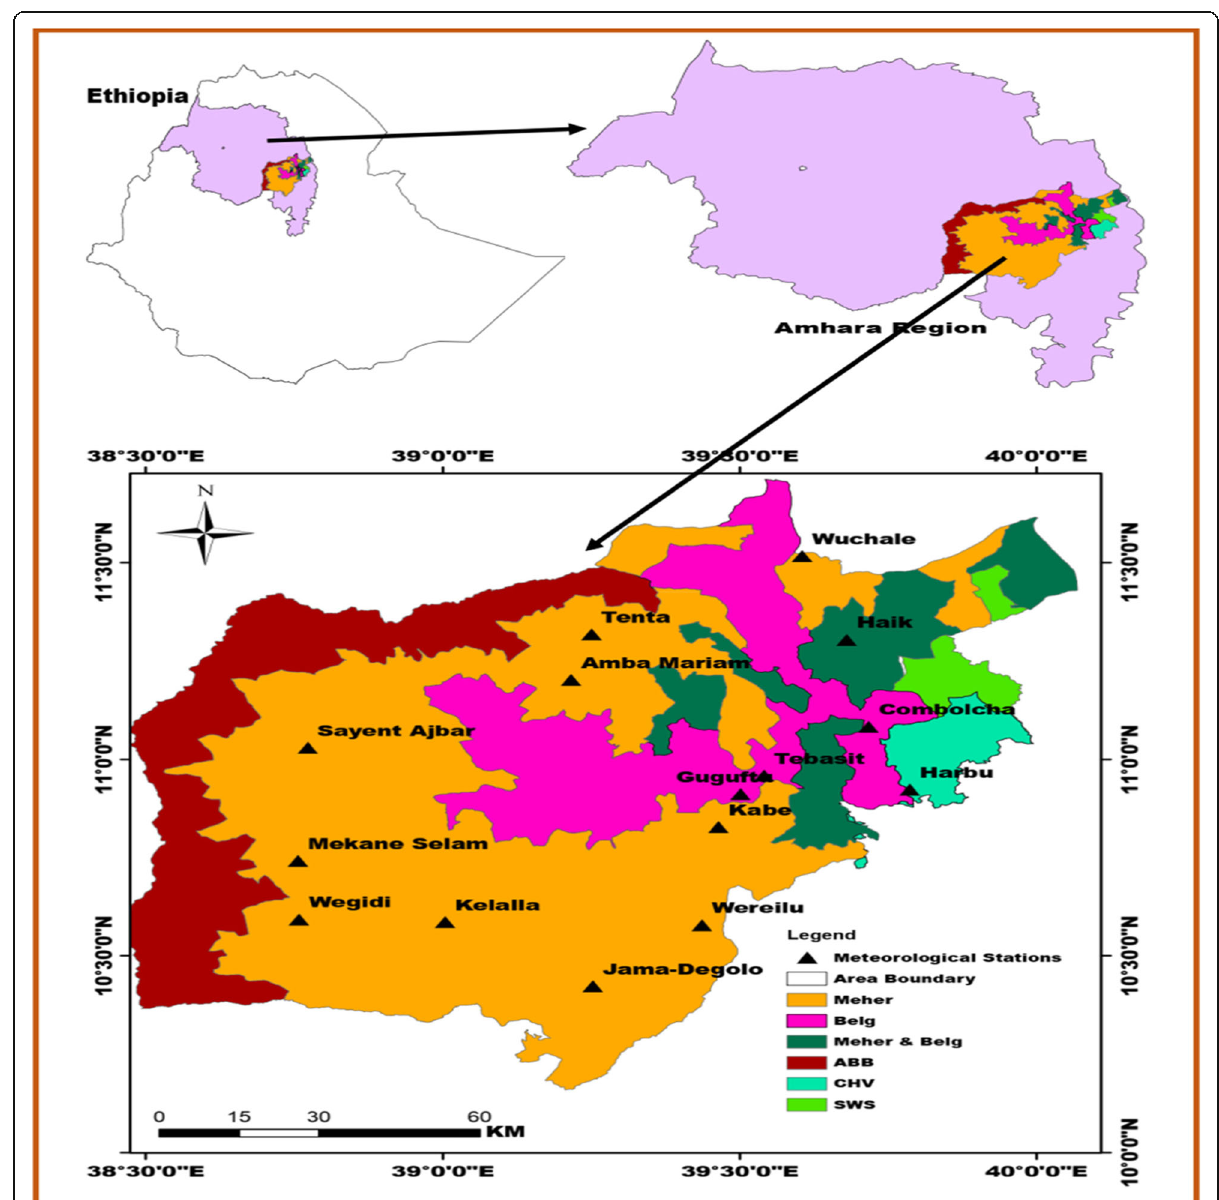
Fig. 1 The geographic location of livelihood zones of South Wollo and Meteorological stations. Source: Extracted from USAID